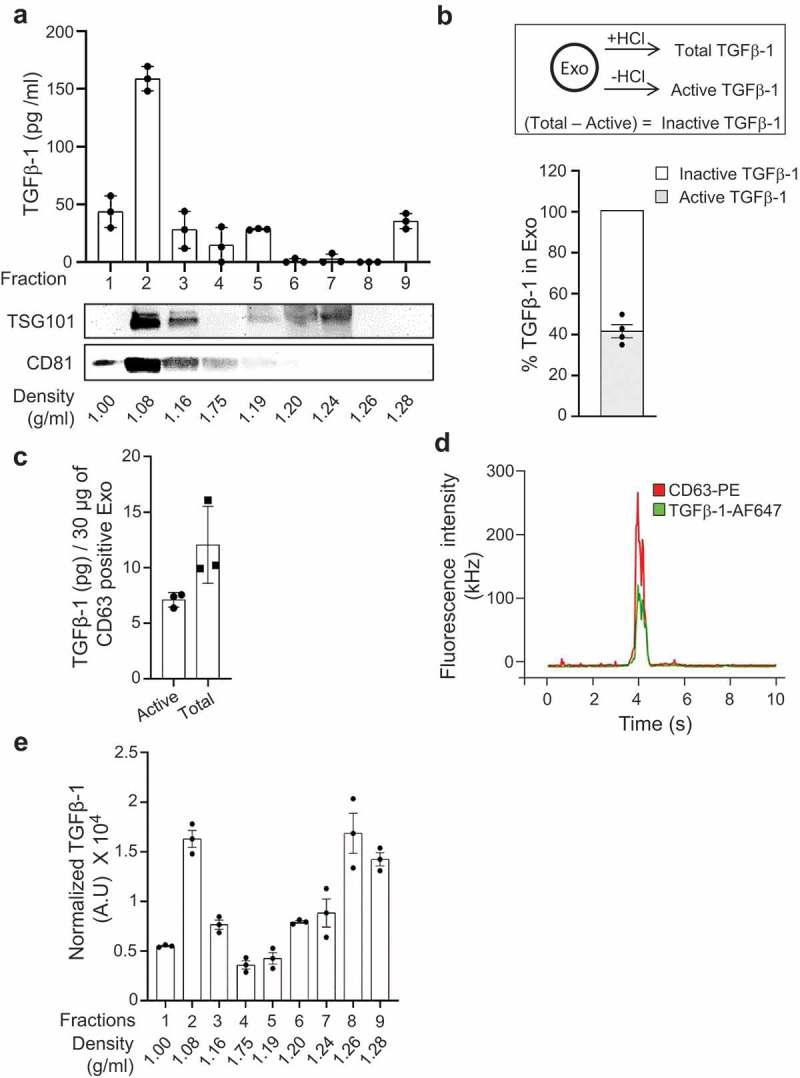
TGFβ-1 co-localizes with exosomes. (a) Exosomes isolated from HMC-1 were floated on iodixanol density gradients, and the expression of TGFβ-1 (ELISA) and the exosome-enriched proteins TSG101 and CD81 (immunoblotting) were measured (n = 3, volume = 600 ml). (b) Percentage of inactive and active forms of TGFβ-1 measured on the mast cell-derived exosomes (n = 3). (c) Amount of inactive and active forms of TGFβ-1 on the mast cell-derived exosomes was measured per unit of CD63-positive exosomes using ELISA. Data are presented as means ± SEM (n = 3). (d) Quantitative measurements of the distribution of TGFβ-1-AF647 (Red) and CD63-PE (Green) on single exosomes using fluorescence correlation spectroscopy (FCS). Excitation was at both 488 nm and 594 nm. The width of the signal, extending to more than 500 ms, corresponds to vesicle diameters. (e) Exosomes were first floated on a density gradient and then incubated on a CD63 antibody-coated on plate, and finally, the relative luminescence signal of TGFβ-1 was measured using the sandwich ELISA approach (n = 3, volume = 200 ml).